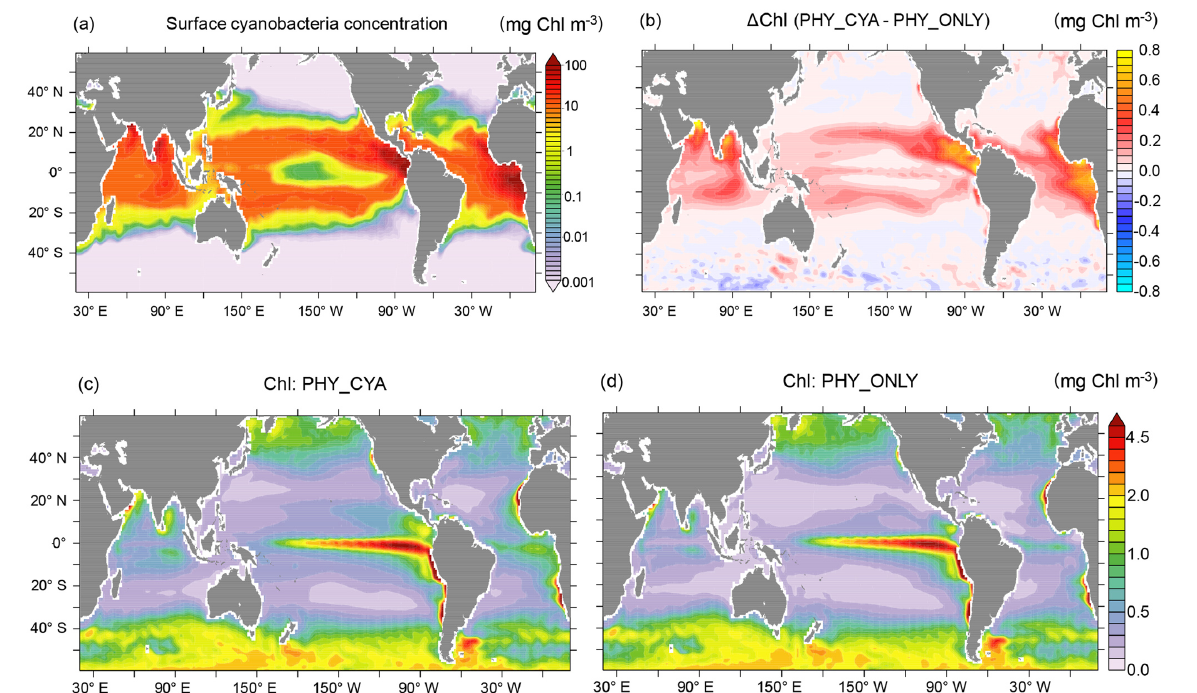
Figure 1. (a) Climatological annual mean cyanobacteria concentrations (mgCm − 3 ) in the upper 22m in PHY_CYA. Note the nonlin- ear color scale. (b) Difference in the climatological annual mean chlorophyll (mgChlm − 3 ) in the upper 22m between PHY_CYA and PHY_ONLY. (c) Climatological annual mean global chlorophyll concentrations (mgChlm − 3 ) in the upper 22m as used for the light atten- uation scheme in the physical model in PHY_CYA, and (d) in